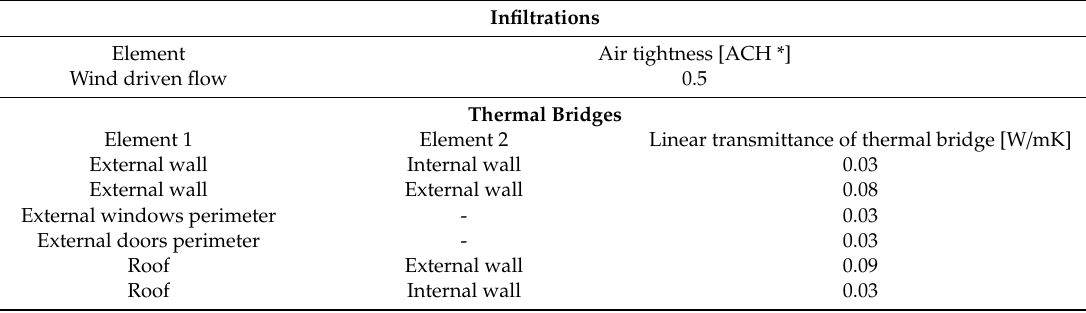
Table 5. Infiltration and thermal bridges.